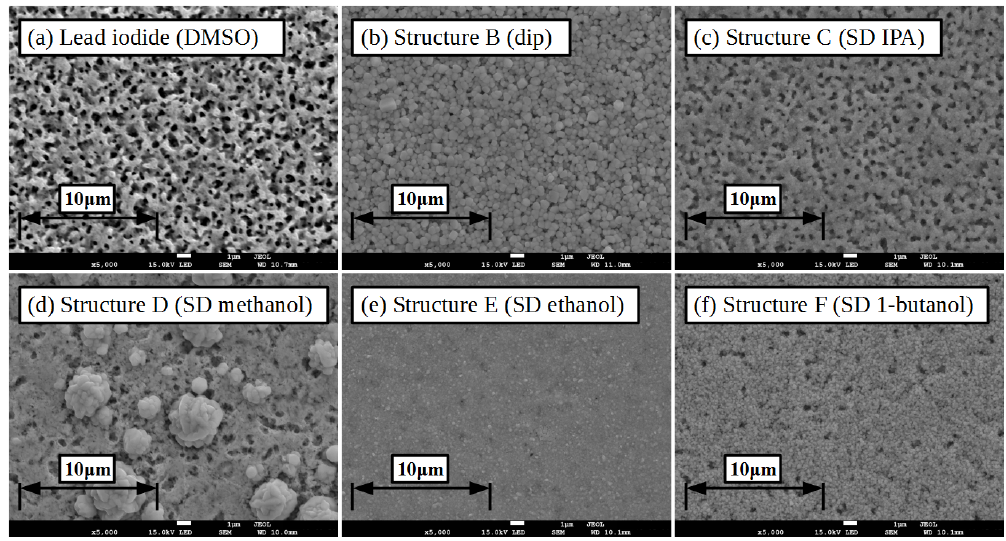
Figure 8. SEM images of initial lead iodide film and perovskite films formed from coating methylammonium iodide on lead iodide coated substrates. Inset scale-bar lengths are given in inset labels. ( a ) Initial lead iodide slot-die coated on room temperature substrate film from DMSO, ( b ) with MAI dip coated, ( c ) with MAI slot-die coated from either IPA, ( d ) methanol, ( e ) ethanol, or ( f )